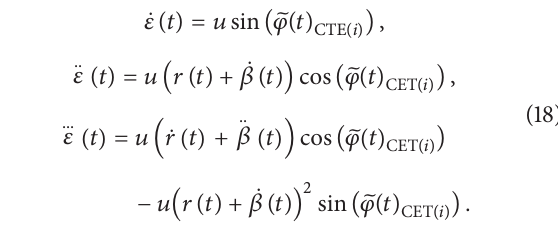
Figure 2: The trajectory following control with no current.